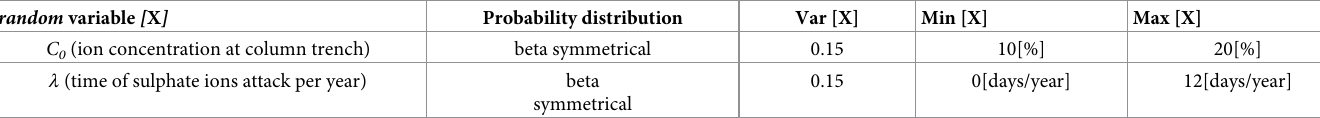
Table 4. Random variables that describe the concrete sulphate aggression process and their descriptions of probability distributions. random variable [ X